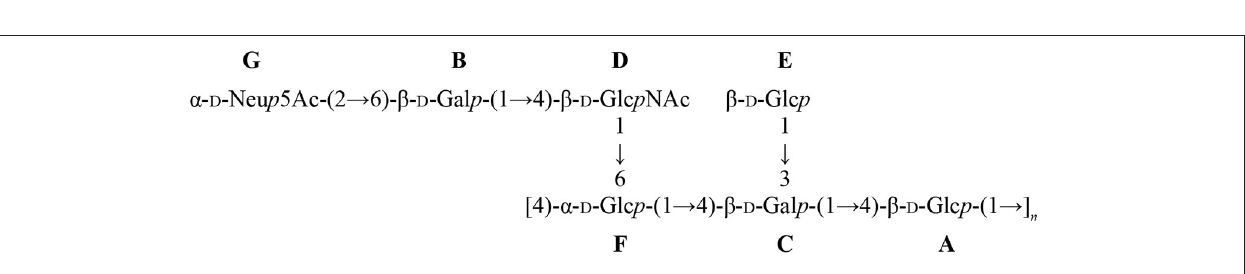
SCHEME 2 | Structure of the GBSVsia2,6 mutant CPS with residue